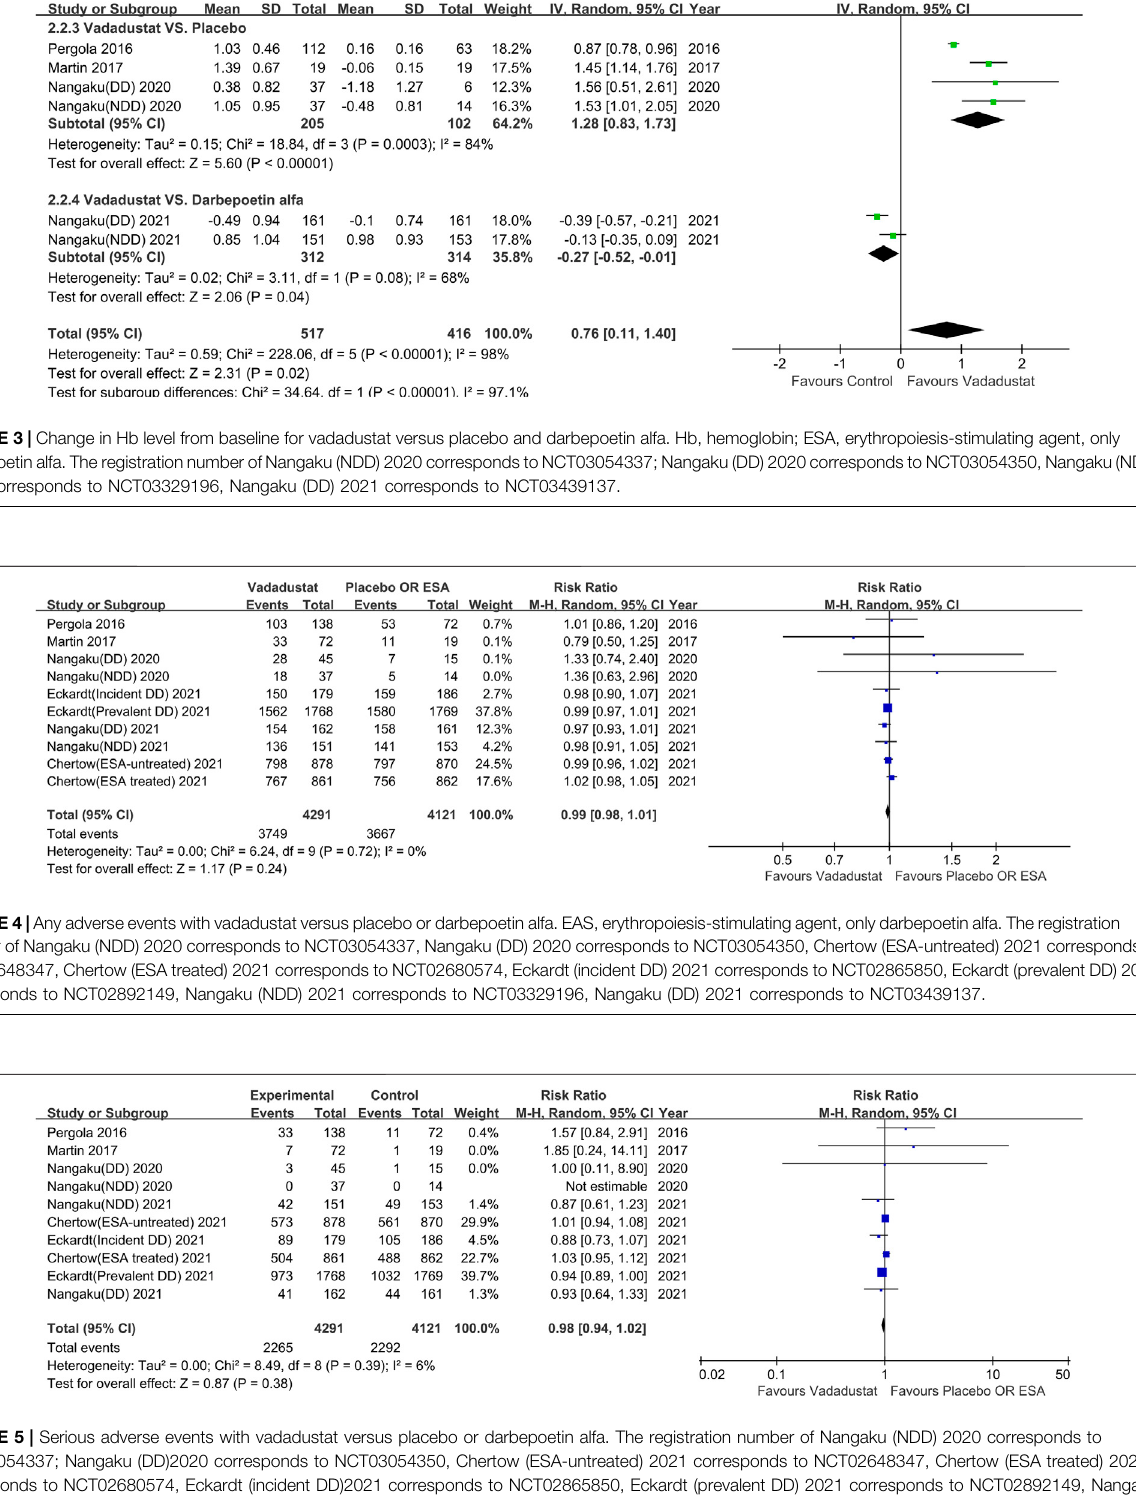
Frontiers in Pharmacology |